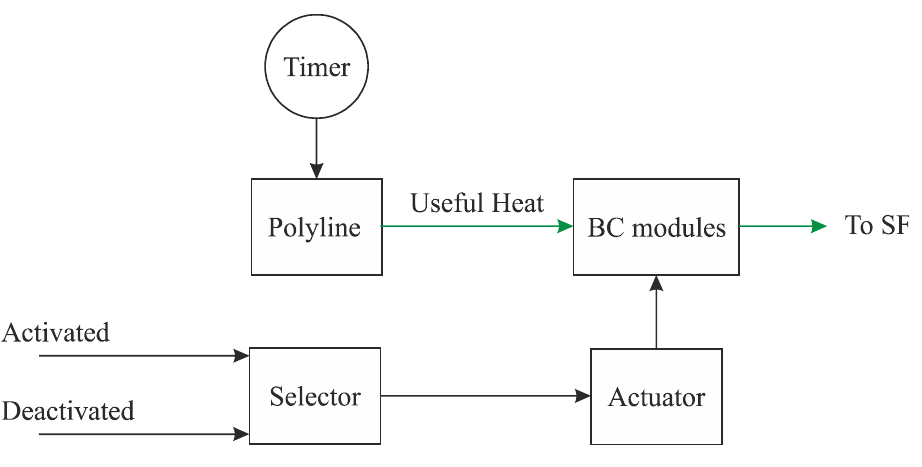
Figure 2. DNI control circuit